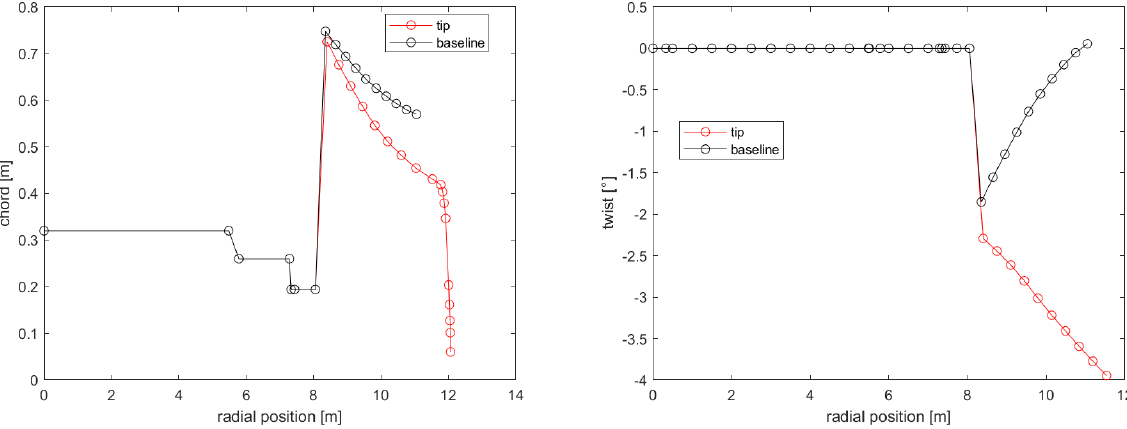
Figure 4. Planform of the optimized tip design compared to the